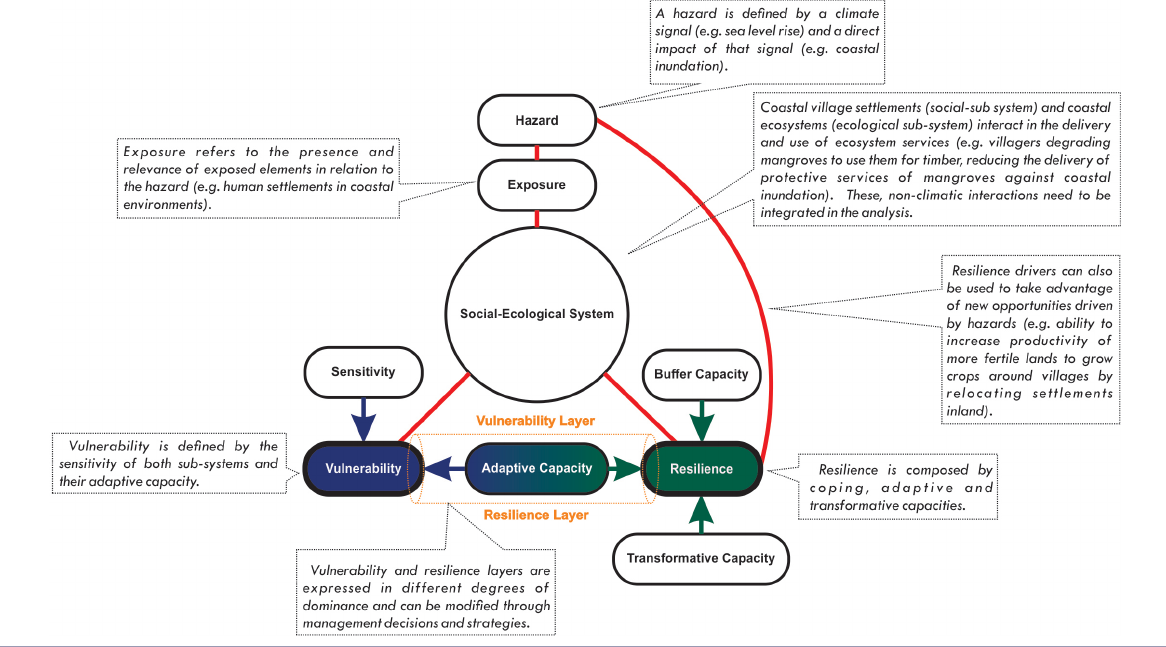
Fig. 2. Conceptual model of multilayered vulnerability and resilience in social-ecological systems, based on the Intergovernmental Panel on Climate Change fifth assessment report (IPCC 2014) risk model. Vulnerability and resilience are linked through the adaptive capacity attribute. Drivers of vulnerability and resilience can be modified to reduce risks or take advantage of new